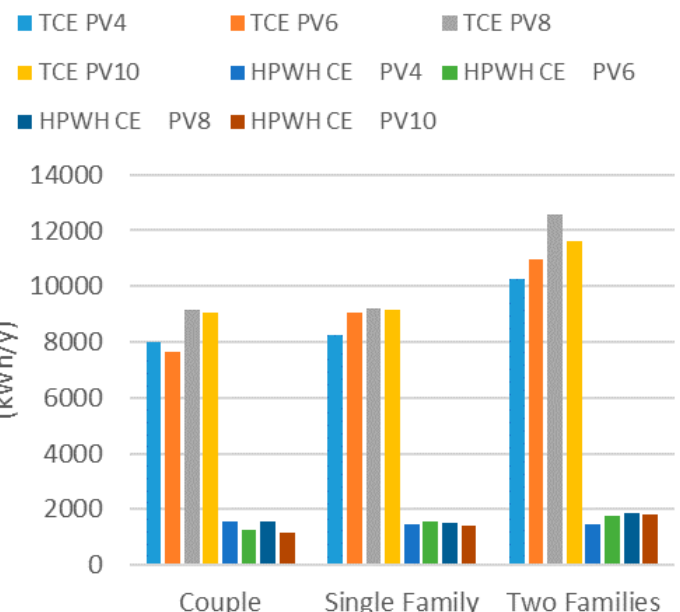
Figure 14. Annual power consumption and HPWH of Family type for PV.